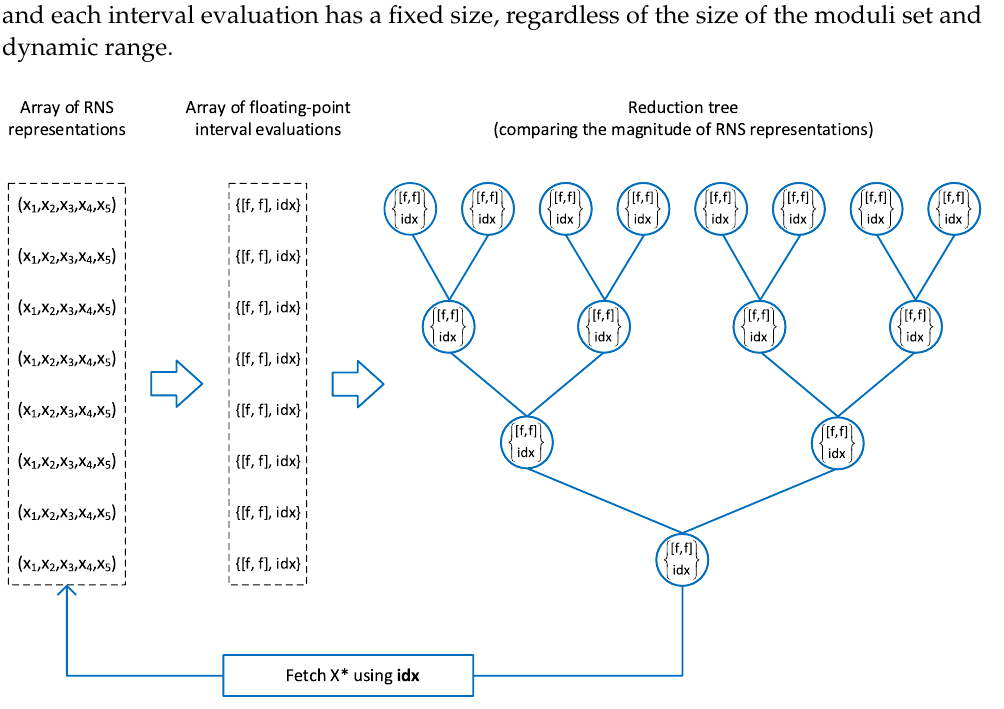
Figure 4. Calculating the maximum element of an array of RNS numbers using floating-point interval evaluations. Each interval evaluation is denoted as [ f , f ] , and idx is the index of the corresponding RNS number in the input